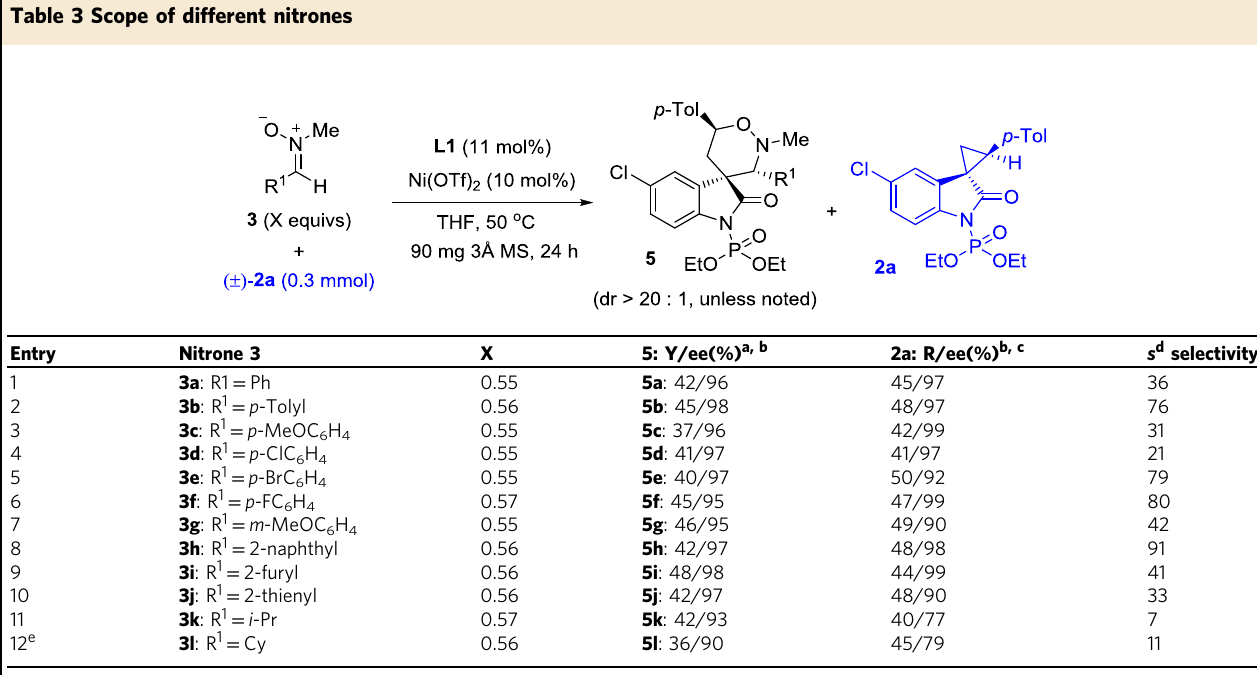
Table 3 Scope of different